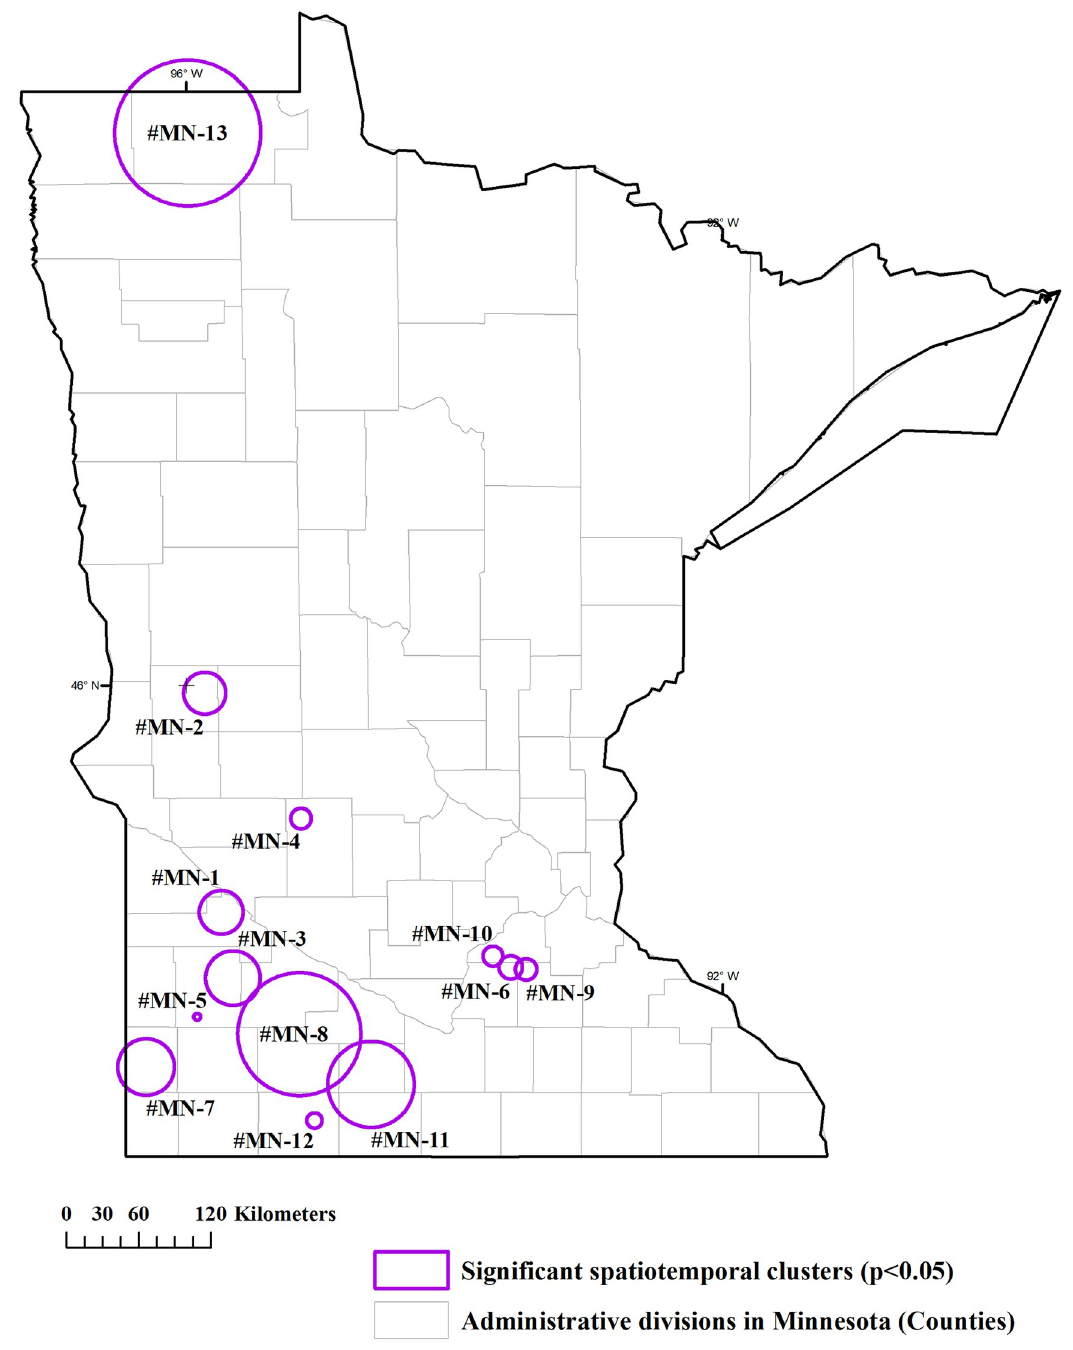
Fig 4. Spatiotemporal clustering of animal Anthrax cases in Minnesota (time: 1912–2014). Clusters were detected using the space-time permutation model of the spatial scan statistic with the spatial-window set to 10% and 5%-time window. Clusters are numbered according to the order of the start date of the